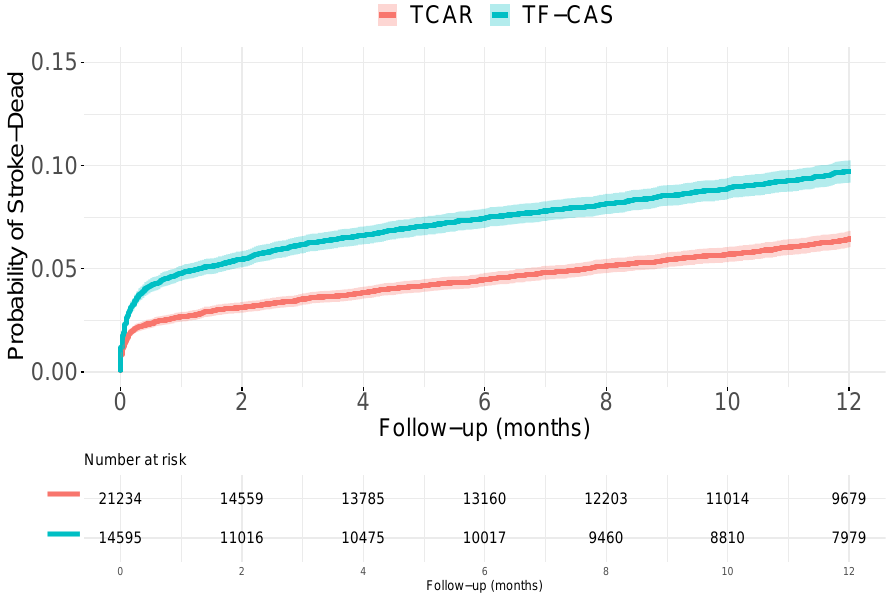
Figure 1. Kaplan–Meier estimations for the observed cumulative distribution functions of dying or having a stroke in both the TF-CAS and TCAR